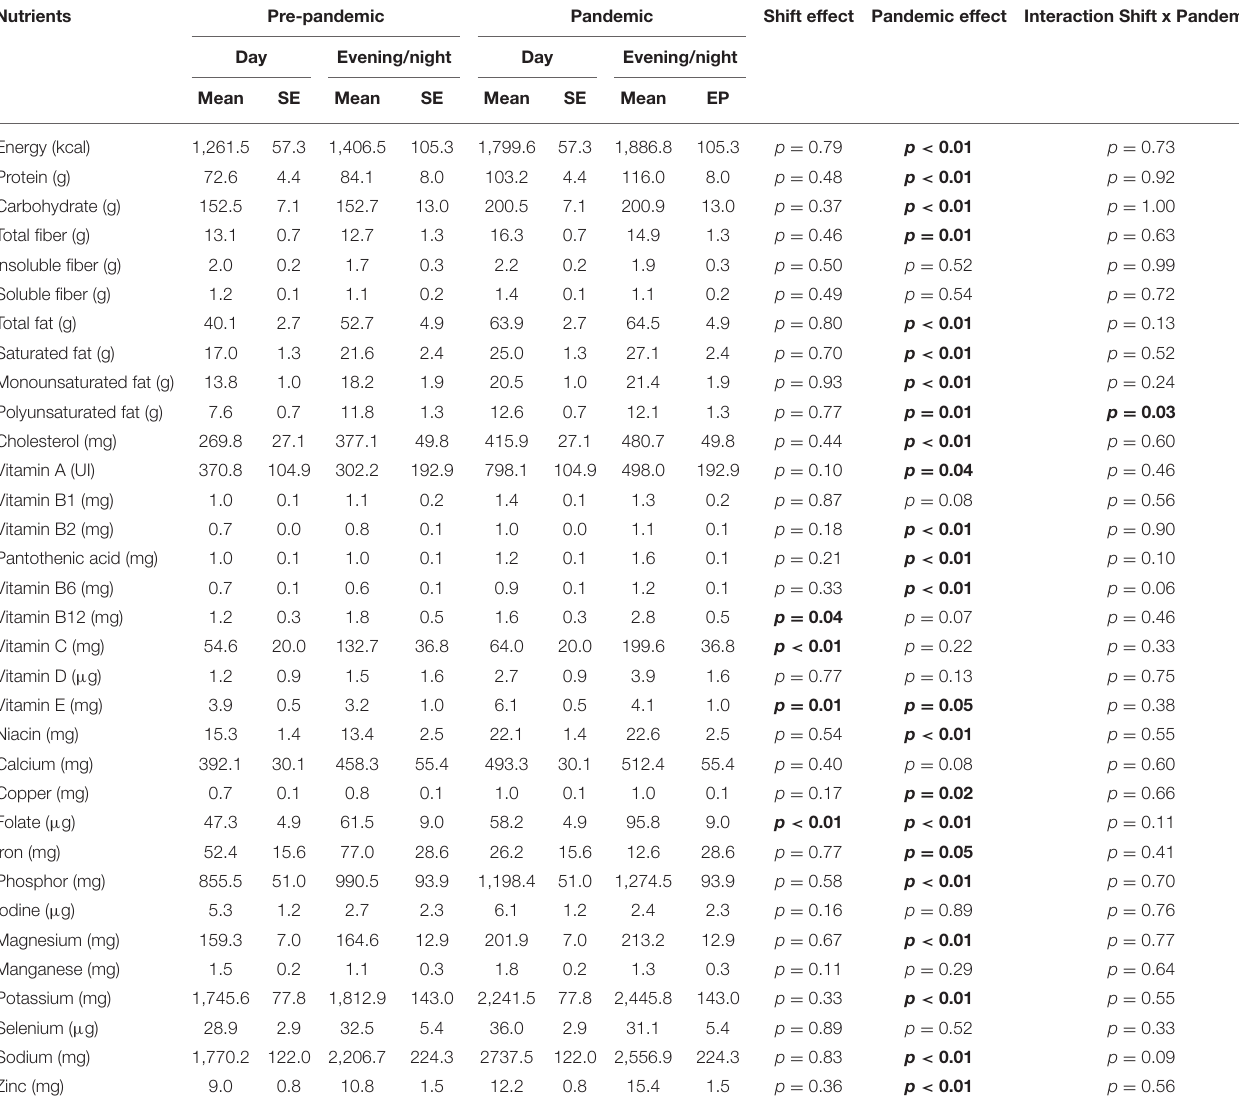
TABLE 3 | Generalized linear model of the variables related to the consumption of nutrients in the pre-pandemic period and during the pandemic per work shift, adjusted for age and sex.